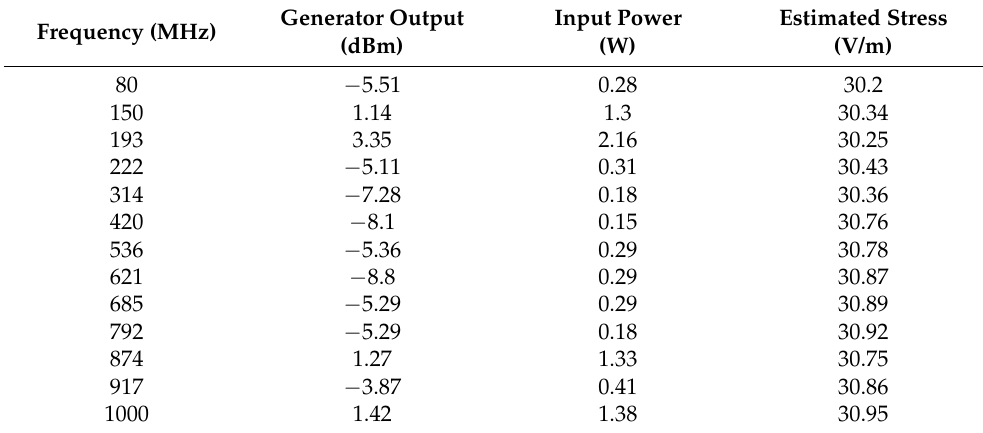
Table 6. Results of immunity tests (sample